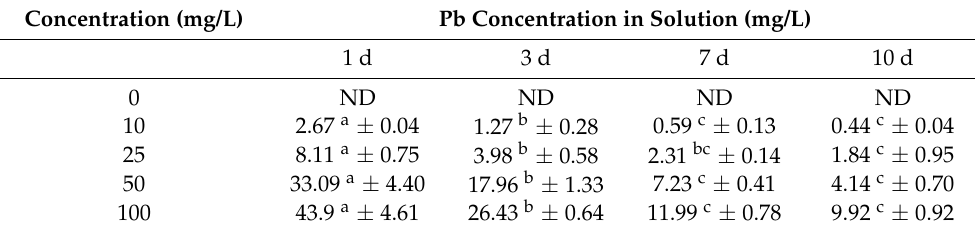
Table 1. Residual lead concentration in solution at different exposure times.